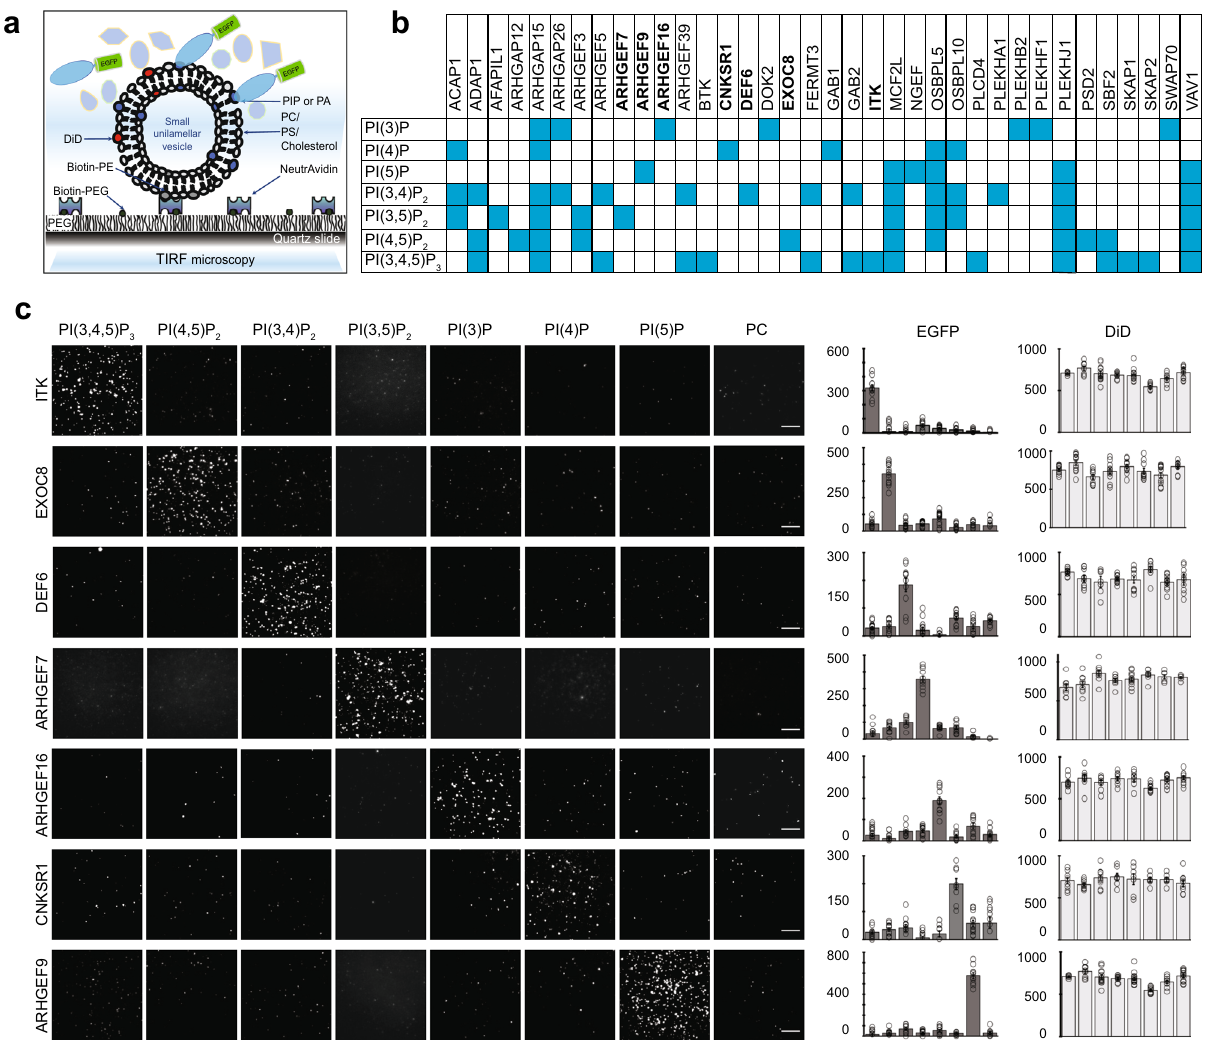
Fig. 1 Speci fi c PIP binding by full-length human PH domain proteins. a Schematic representation of the lipid-SiMPull assay to detect lipid – protein interactions. Adapted with permission from Arauz et al. 17 Copyright 2016, American Chemical Society. b A binary representation of results for the 36 proteins found to bind PIPs in SiMPull. The vesicles are identi fi ed by the unique PIP, but all contained PC, PS, cholesterol, DiD, and biotin-PE. Blue: binding; white: no binding. SiMPull data for the proteins in bold are shown in ( c ). c Representative TIRF images of seven EGFP-fusions pulled down by vesicles containing 5% PIP, with PC as a negative control. Scale bars: 5 µ m. Numbers of fl uorescent molecules per image area are shown in the graphs on the right. Data are presented as mean ± SEM. N ≥ 10 images for EGFP; N ≥ 6 images for DiD. Source data are provided as a Source Data fi le, which lists the exact N number for each data point. 1 – 8: PIP 3 , PI(4,5)P 2 , PI(3,4)P 2 , PI(3,5)P 2 , PI3P, PI4P, PI5P, PC. Each assay was repeated with lysates from at least